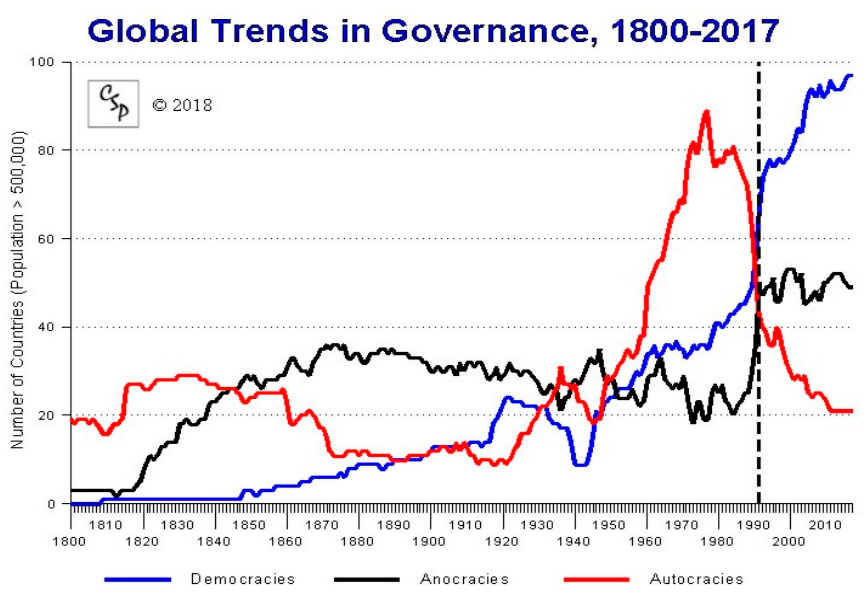
Figure 1. Source: Polity IV (2013). Downloaded from http://www.systemicpeace.org/polity/polity1.htm (accessed on 27 September 2021).